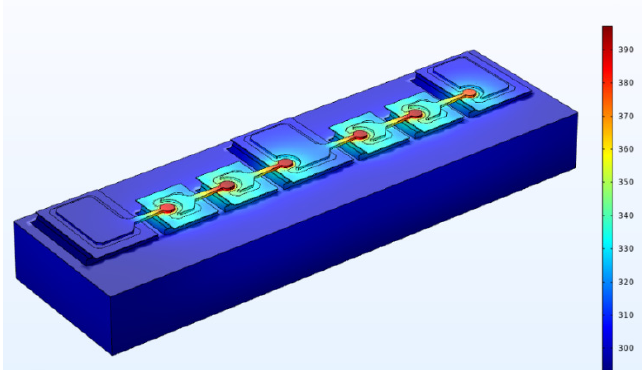
Figure 9. The overall temperature distribution of the Schottky diode (the temperature scale represents the absolute temperature in kelvins).